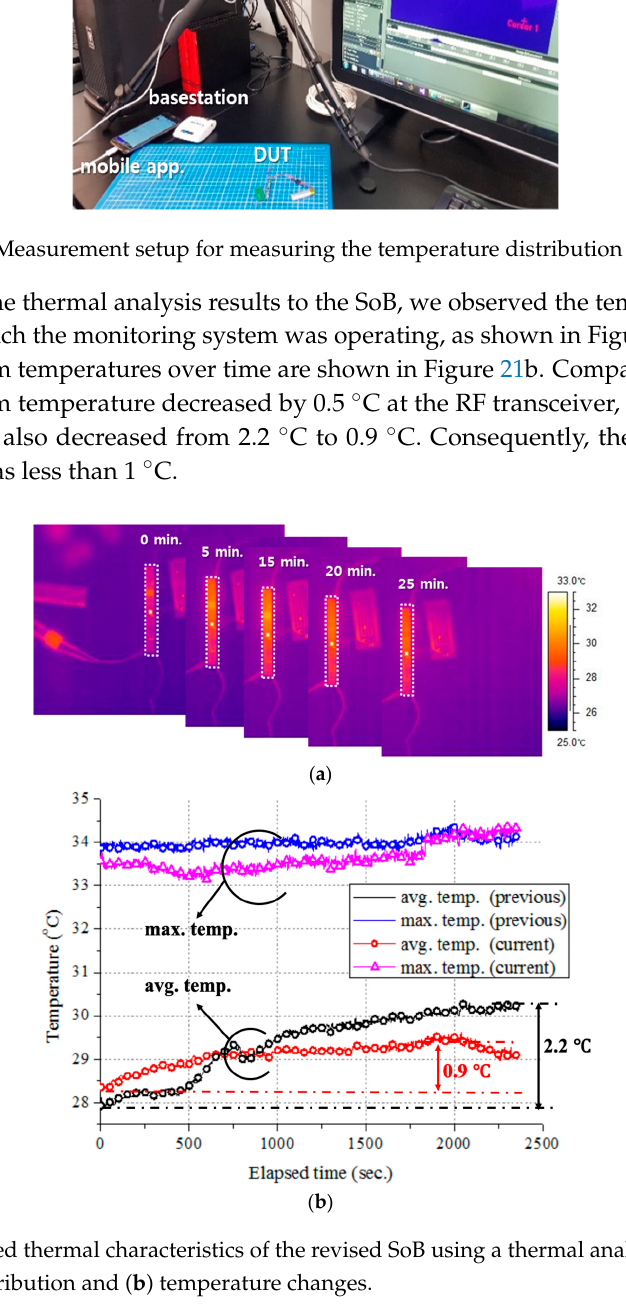
Table 2. Parameters and performance of the receiving coil.